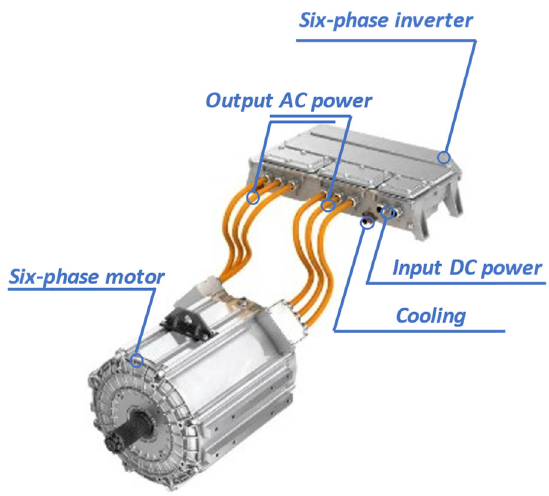
Figure 29. DANA TM4 SUMO TM MD six-phase drive [161].